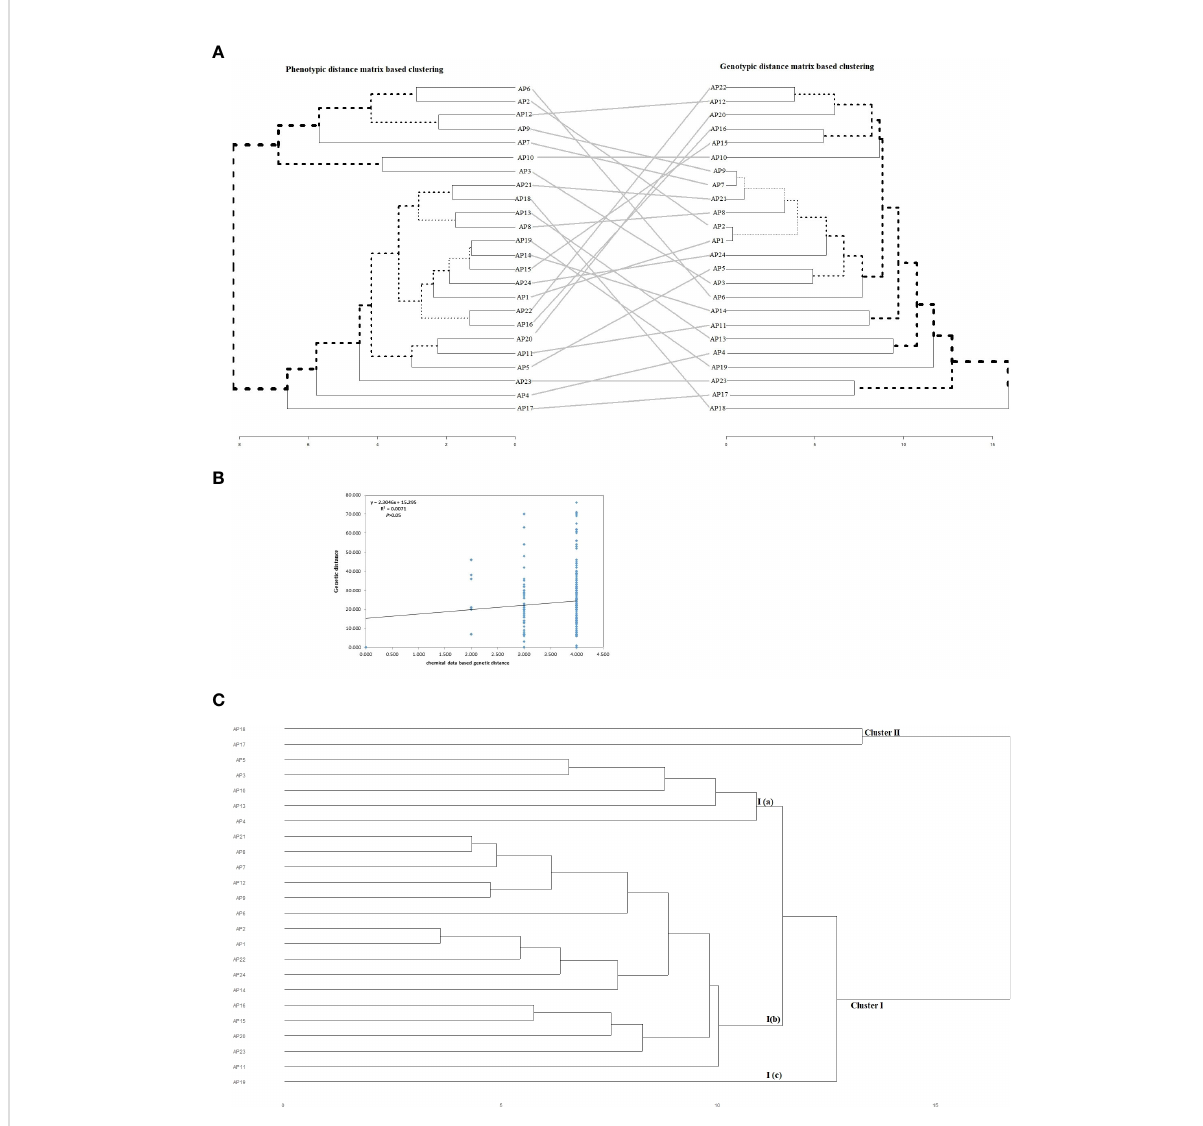
FIGURE 7 (A) Comparative assessment of phenotypic and genotypic data based hierarchical cluster dendrograms. The black lines represent mismatched accessions in-between the two dendrograms from the phenotypic to the genotypic cluster. (B) Mantel test representing the relationship between phytochemical and molecular data sets. (C) Hierarchical clustering of twenty-four accession of kalmegh using combined agro- phytochemical and molecular